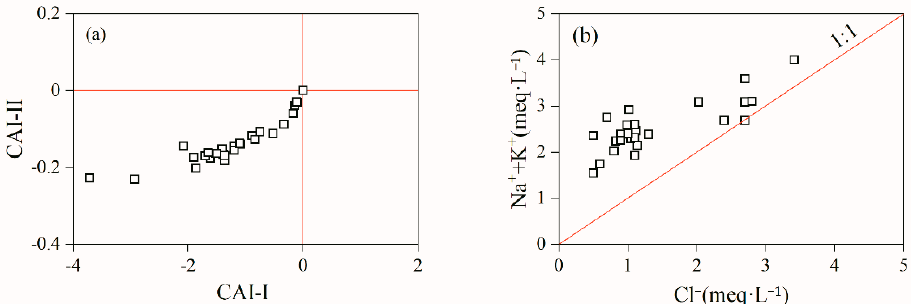
Figure 6. Chloro-alkaline indices ( a ) and the relationship between Na + + K + and Cl − ( b ) in Sr-rich groundwater.